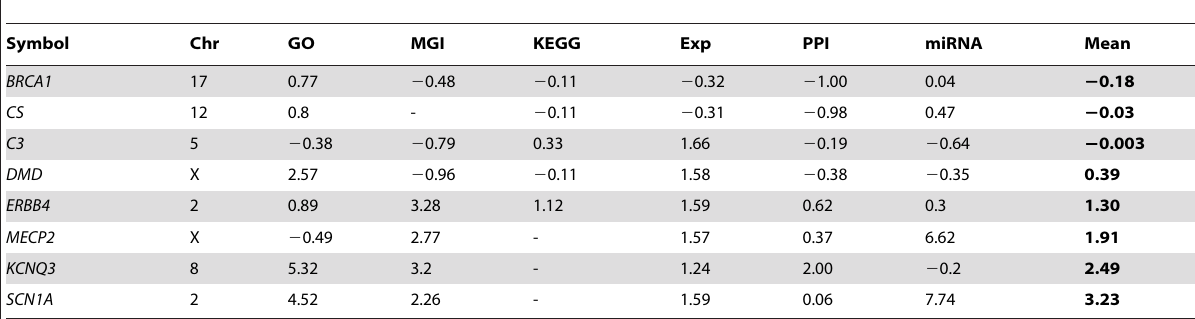
Table 1. Individual feature and composite pathogenicity scores of selected genes.